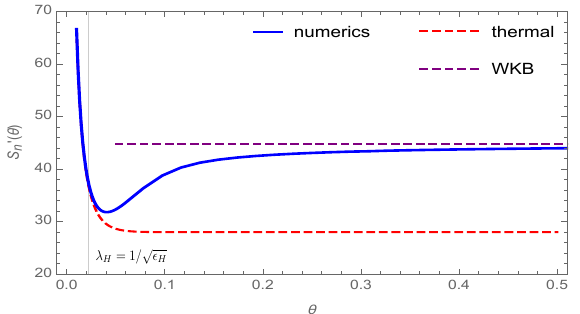
Figure 14 . Comparison between the WKB prediction, high temperature thermal behavior and 6 numerical result for lim c S 0 ( (cid:18) ), with n = 4, and (cid:15) H = 2000. The gray verticle line marks the n c !1 thermal scale (cid:21) H = 1 = p (cid:15) H